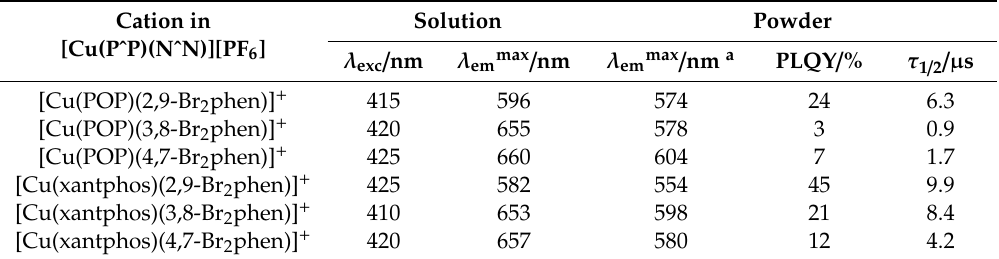
Figure 8. Normalized solution emission spectra of the [Cu(PˆP)(NˆN)][PF 6 ] compounds in CH 2 Cl 2 (concentration ca. 2.0 × 10 − 5 mol dm − 3 ). See Table 4 for λ exc . Table 4. Room temperature solution emission maxima (CH 2 Cl 2 , ca. 2.0 × 10 − 5 mol dm − 3 ) and solid-state emission maxima, PLQY values and excited-state lifetimes for the [Cu(PˆP)(NˆN)][PF 6 ] compounds.